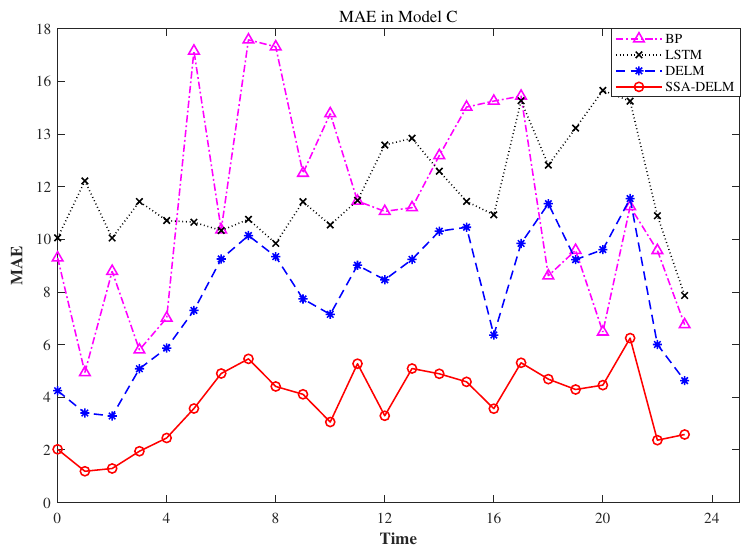
Figure 5. MAE of various algorithms under model